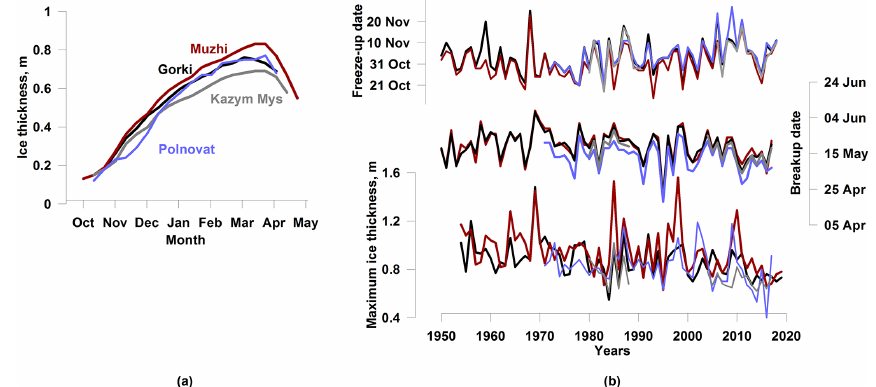
Figure 2. Examples of (a) seasonal evolution of ice thickness (1980–2017 mean) and (b) interannual variability of ice freeze-up and the end of breakup dates and maximum ice thickness at four stations (Gorki, Muzhi, Polnovat and Kazym Mys).